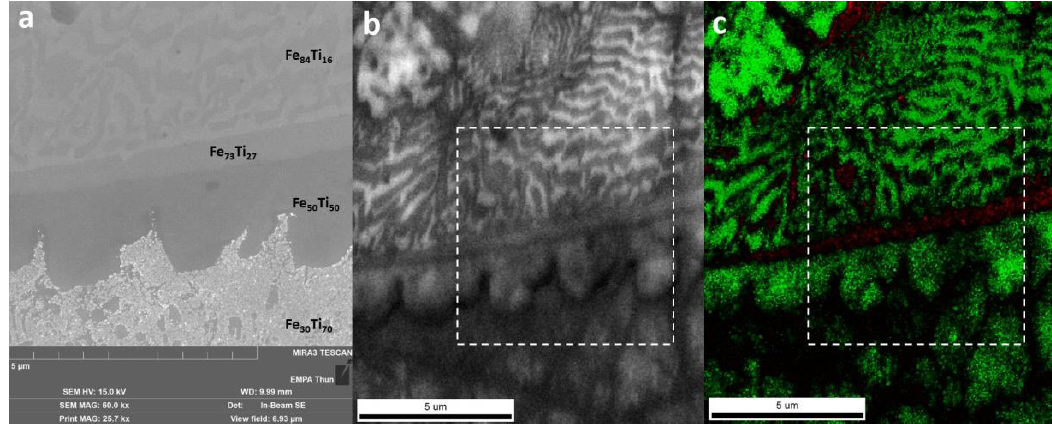
Figure 9. ( a ) SEM image of the upper border of the Ti-rich eutectic band in Wall_NL_5. Compositions are indicated by atomic ratios. This area is indicated by white boxes in the following electron backscatter diffraction (EBSD) maps. ( b ) EBSD image quality (IQ) map. ( c ) EBSD phase map (green for b.c.c. generic and red for h.c.p. generic) with CI (brightness indicates confidence of indexing).